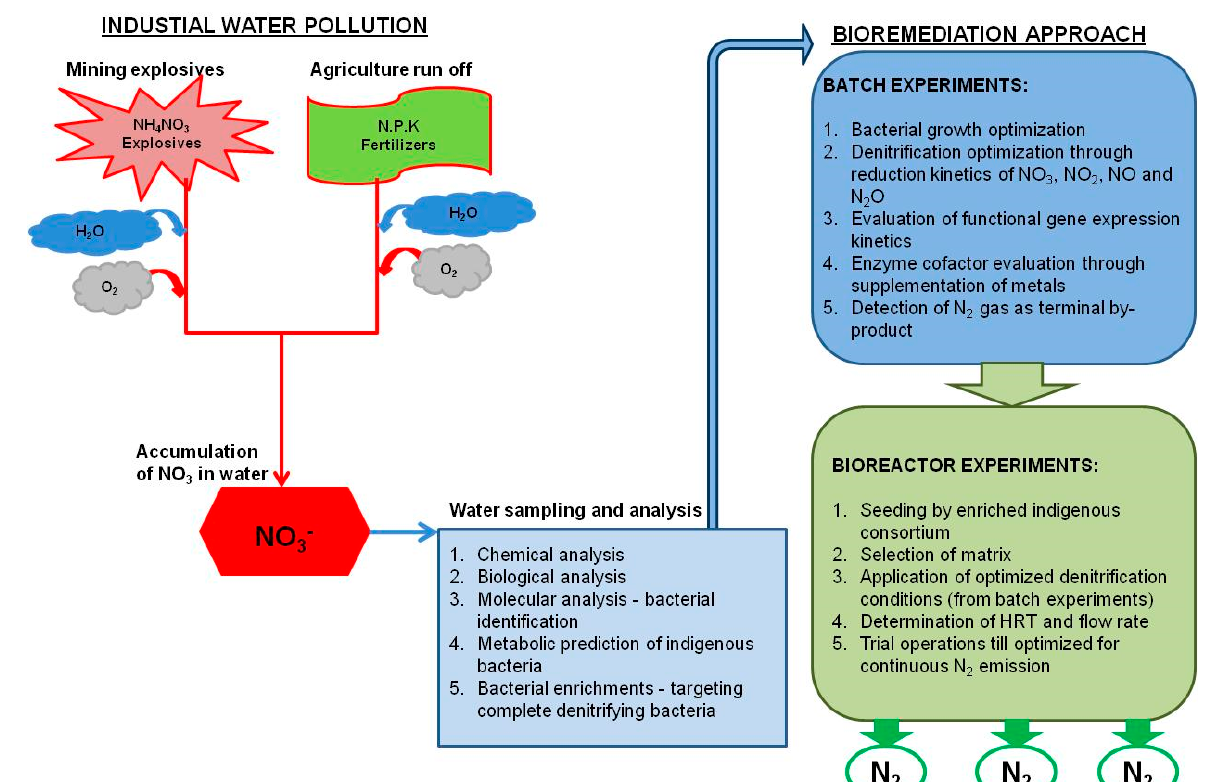
Figure 4. Proposed approach for nitrate bioremediation of industrial wastewater optimizing for complete denitrification with indigenous bacteria from the contaminated wastewater.